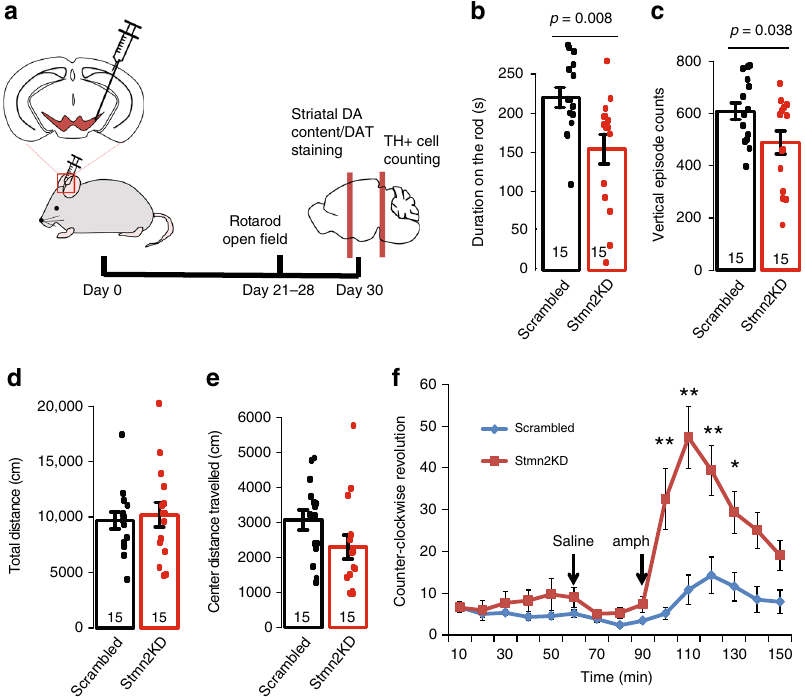
Fig. 5 Locomotor behavioral analysis in mice with AAV-mediated Stmn2 knockdown. a The schematic of the experimental design. AAV carrying scrambled shRNA or Stmn2 -targeting shRNA was injected in the right SN. Behavioral tests were performed from day 22 to day 27 post injection. b The injected mice were examined on the rotarod. The average of three trials was used to represent the performance of each individual mouse. N = 15 in each group. Student ’ s t test, two-sided, t = 2.873, df = 28, p -value = 0.008. c – e The injected mice were examined in open fi eld. The vertical episode count ( c t = 2.1851, df = 28, p -value = 0.038), total distance ( d t = − 0.36436, df = 28, p -value = 0.3592), and center distance traveled ( e t = 1.7304, df = 28, p -value = 0.094) were compared between the control and Stmn2 knockdown mice. N = 15 in each group, two-sided Student ’ s t test for two group comparison. f The injected mice were also examined in open fi eld at baseline, under saline injection, and under amphetamine injection. The counter-clockwise revolution was compared between the control group and Stmn2 knockdown group. N = 15 in each group, two-way ANOVA, df = 1, F = 75.951, p = 2E-16 between control and Stmn2 knockdown; df = 14, F = 13.669, p = 2e-16 between time points and df = 14, F = 6.244, p = 2.27E-11 for interacting terms; post hoc comparison was performed using Tukey HSD test *<0.05, **<0.01. All data are present as mean ± SEM. Source data are provided as a Source Data fi le